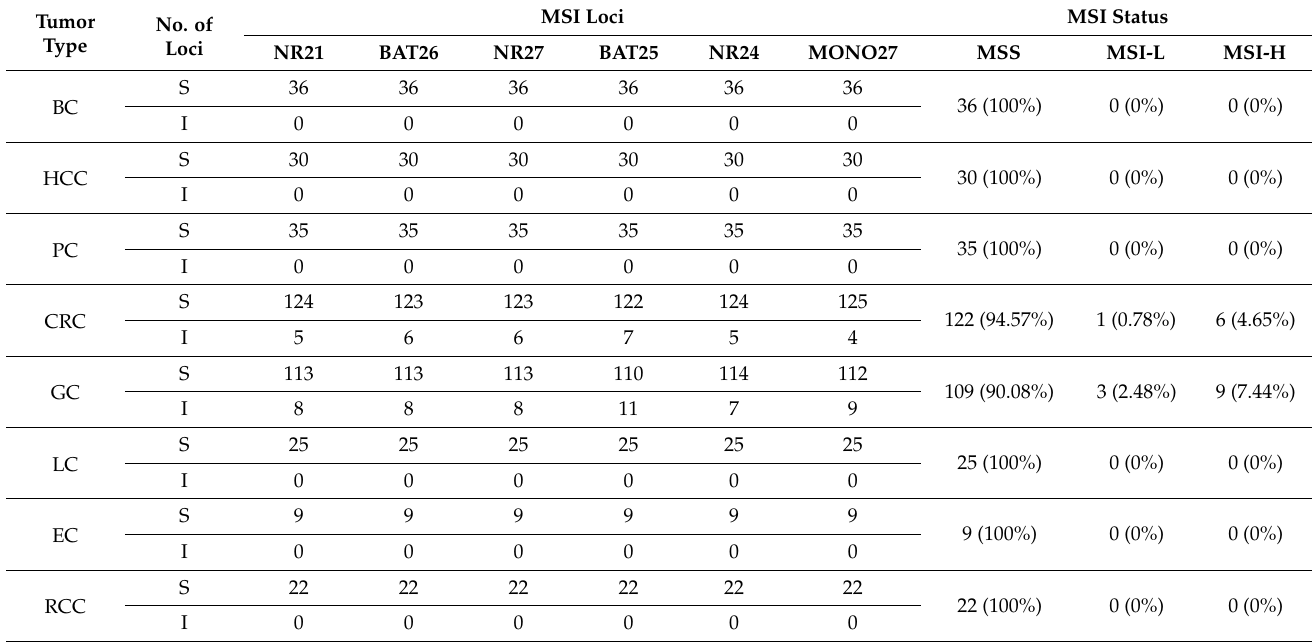
Table 2. Microsatellite instability (MSI) status of the 407 paired cancer samples across the eight tumor types. S refers to stable, which refers to the locus without alterations; I is short for instable, which refers to alterations in the locus. BC ( n = 36); HCC ( n = 30); PC ( n = 35); CRC ( n = 129); GC ( n = 121); LC ( n = 26); EC ( n = 8); RCC ( n = 22).